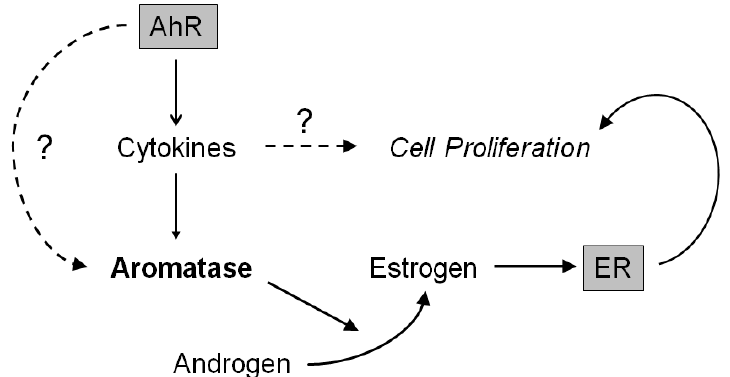
Figure 6. A summary of the proposed AhR pathway in human osteoblasts. AhR, aryl hydrocarbon receptor; ER, estrogen receptor.